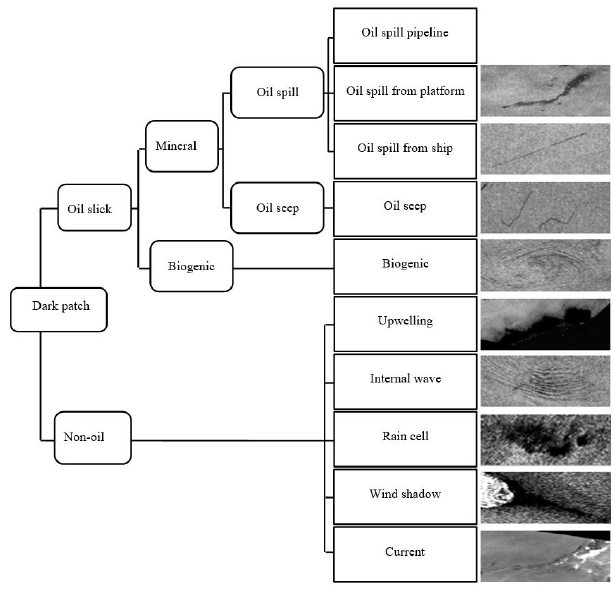
Figure 6. The main offshore dark patches seen in SAR images (Na- joui et al.,